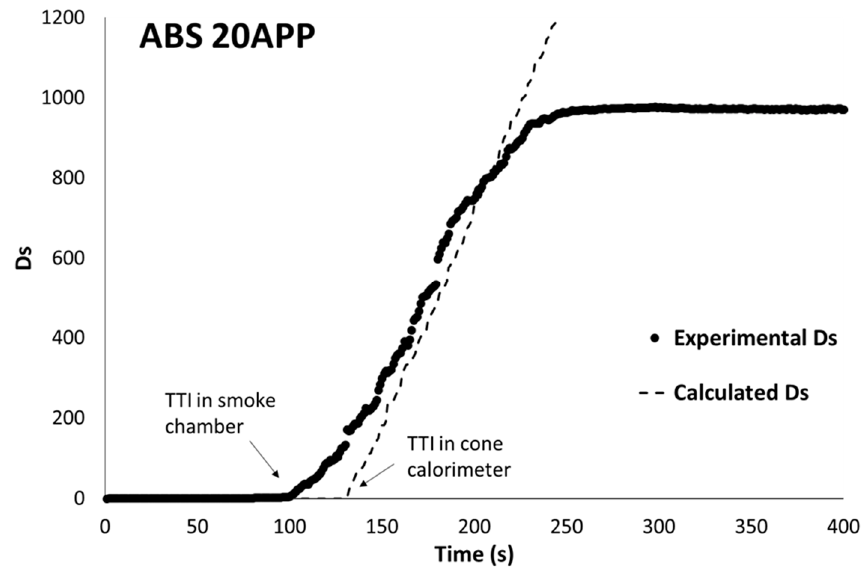
Figure 11. Calculated and experimental Ds versus time in smoke chamber for ABS filled with 20 wt% APP.